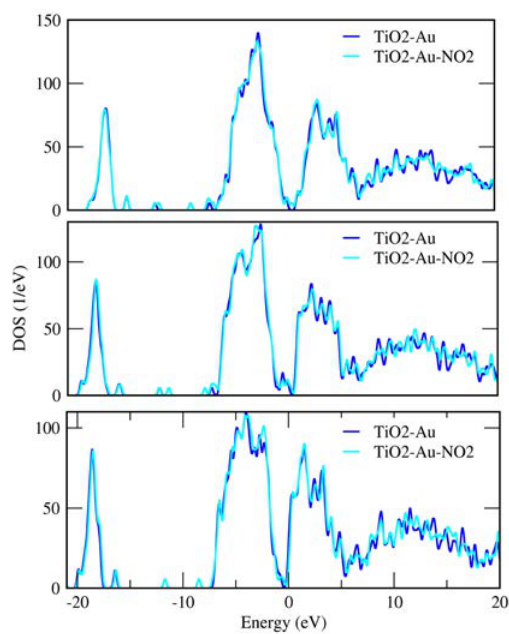
Fig. 8. DOS for the pristine and two types of N-doped TiO2/ Gold nanocomposites. a: A complex; b: B complex and c: C complex. The Fermi energy is set to zero denoted by orange solid